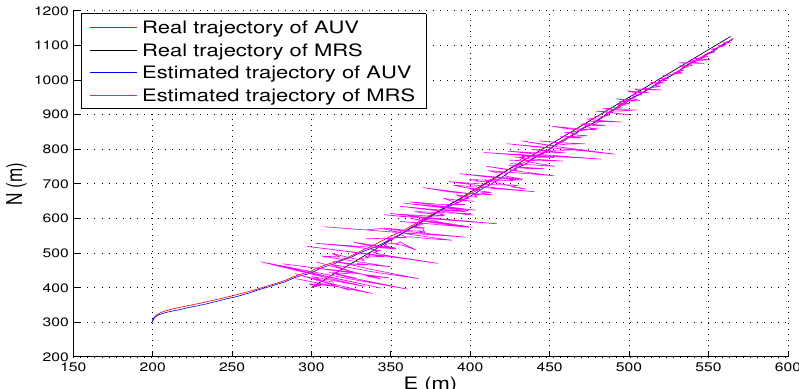
Figure 9. The real trajectory and estimated trajectory of AUV and